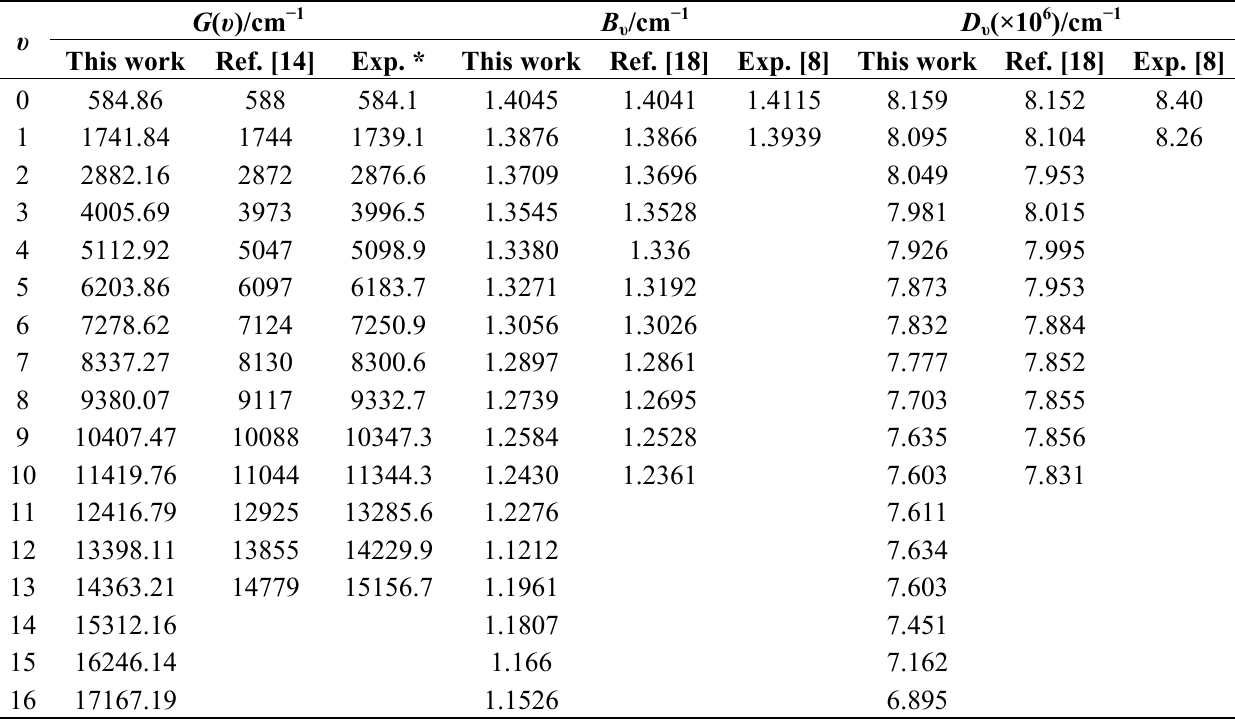
Table 6. Comparisons of vibrational levels and molecular constants with experiments and theories calculated for BeF(A 2 Π ) radical when J = r